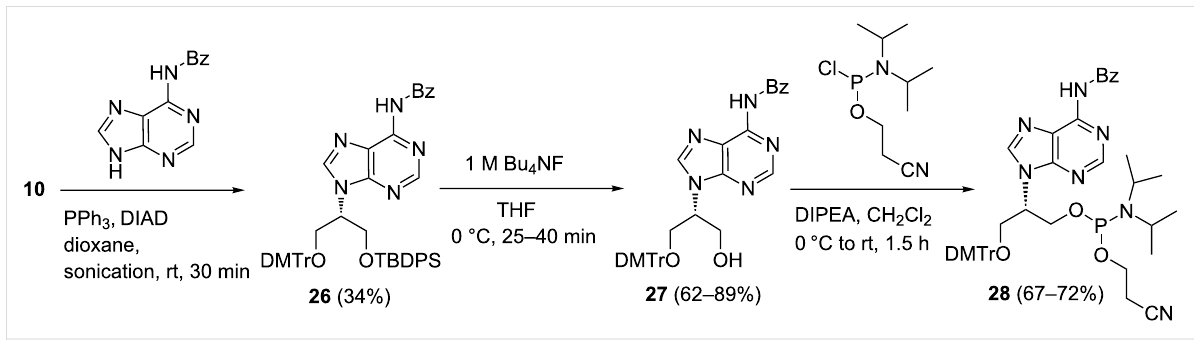
Scheme 4: Preparation of adenine containing phosphoramidite of isoGNA.